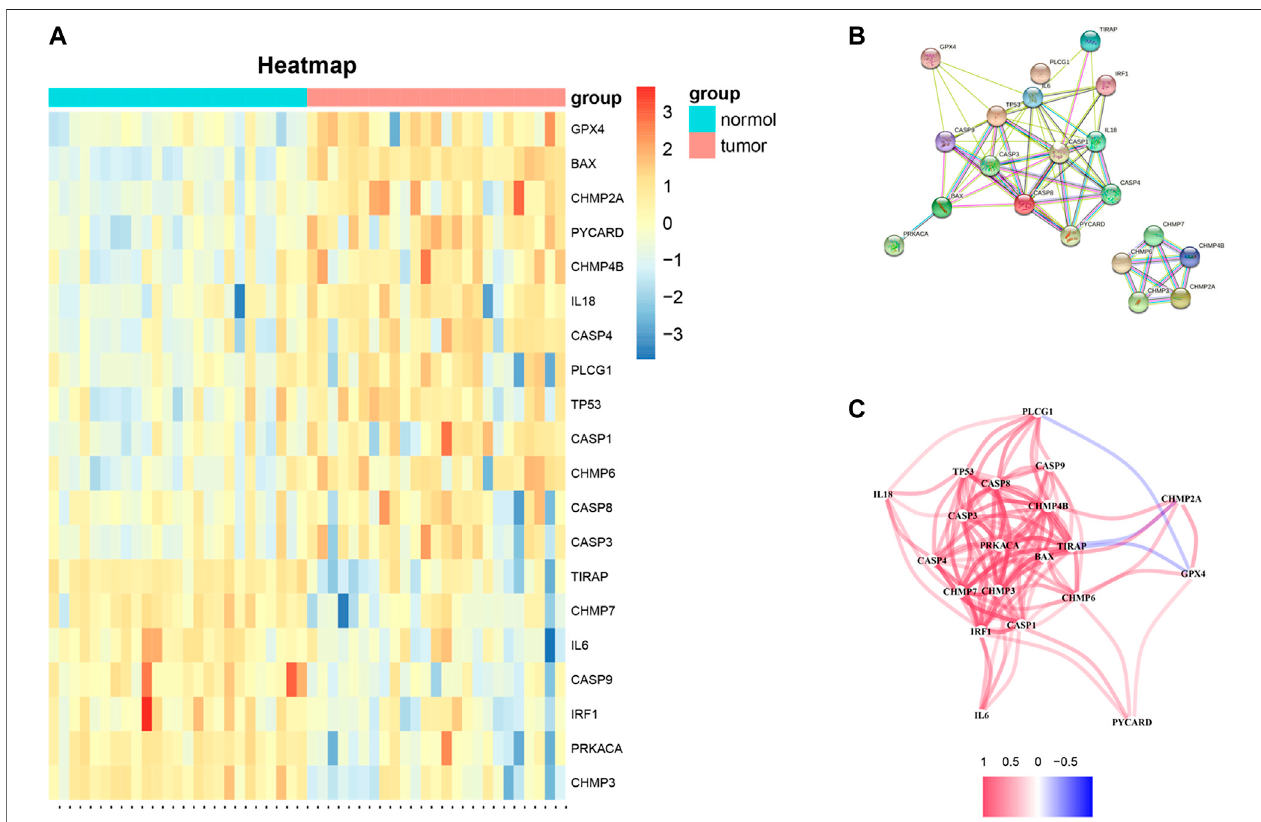
FIGURE1|(A) Heat-mapofdifferentiallyexpressedPRGsbetweenthetumorandnormaltissues(redcolor:higherexpression;bluecolor:lowerexpression,all p < 0.05). (B) PPI network of 20 differentially expressed PRGs obtained from the STRING database. (C) Correlation network of 20 differentially expressed PRGs (the correlation coef fi cients are presented by different colors: red line, positive correlation; blue line, negative correlation).